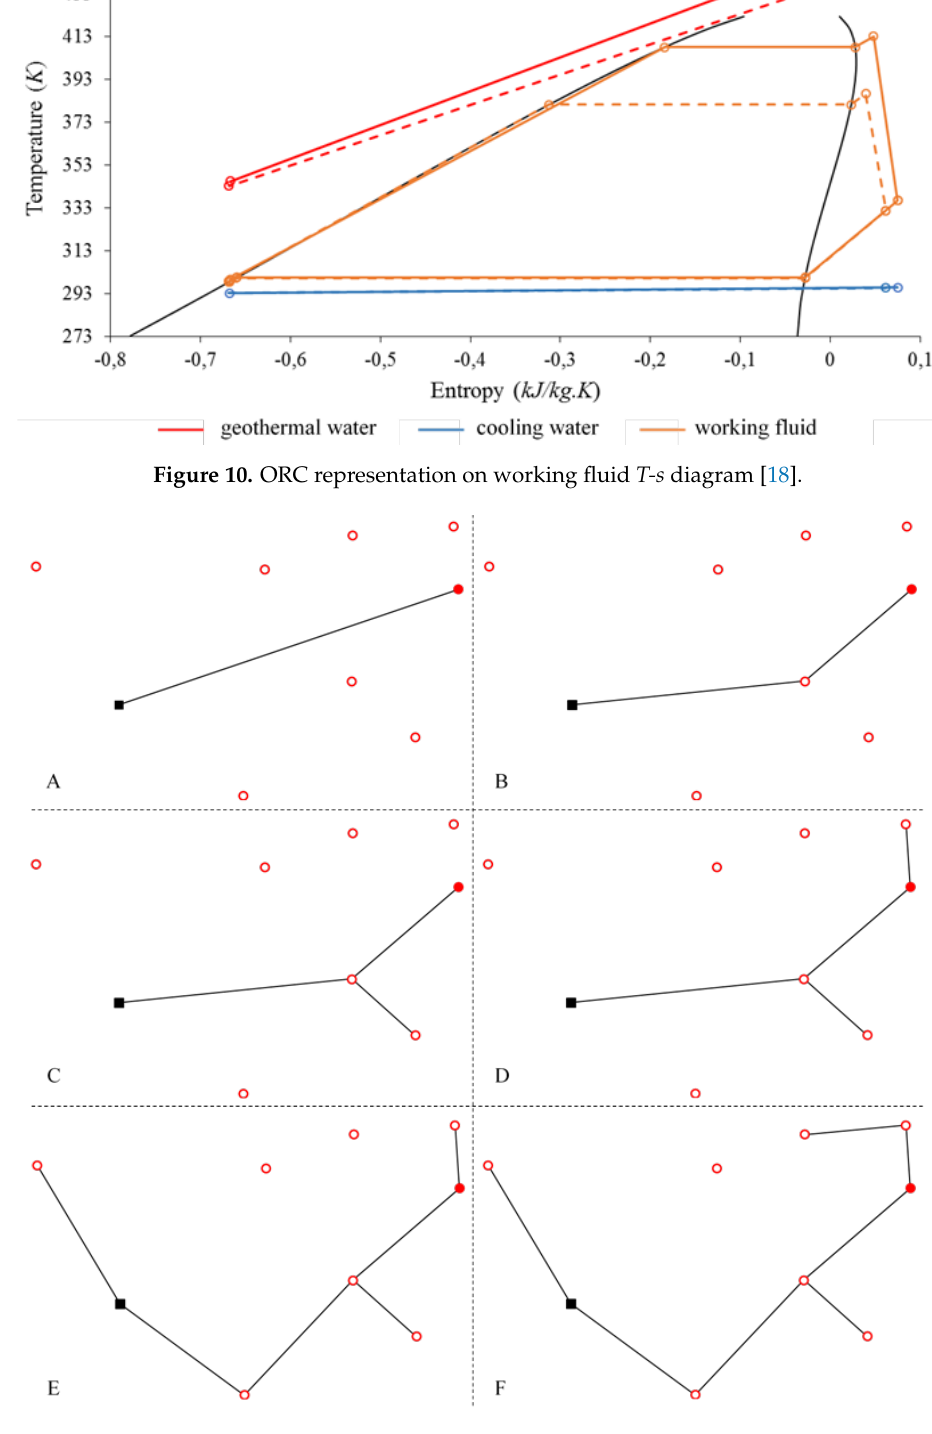
Figure 11. Evolution of the DHN configuration during the temperature decrease.